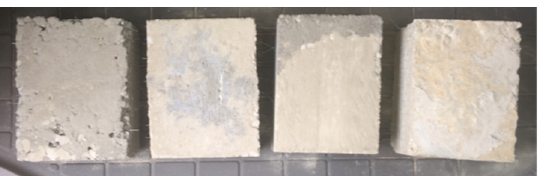
Fig. 13: Top (plan) view of the concrete blocks after being removed from their molds